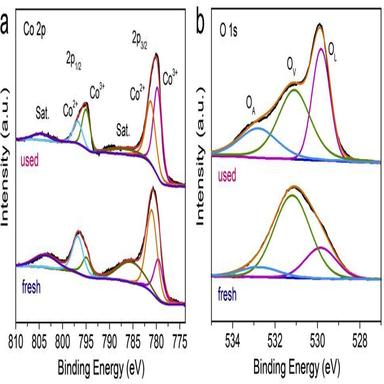
XPS analysis of the fresh and used MS-VO-Co3O4: (a) Co 2p and (b) O 1s.